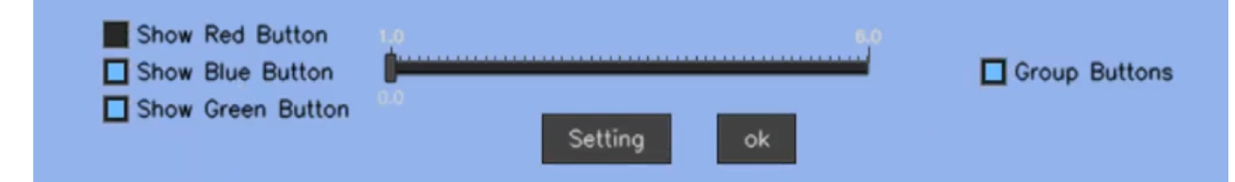
Fig 8. Manual AUI adaptation